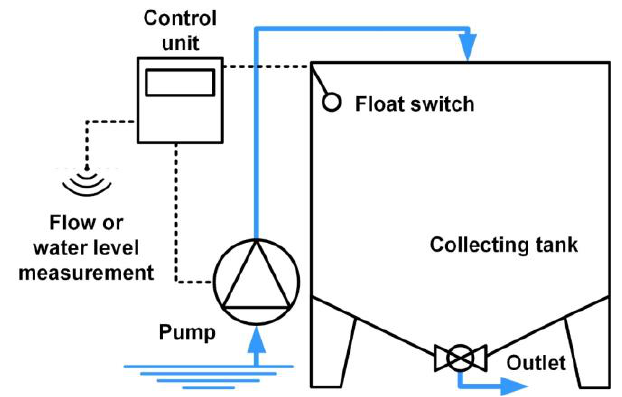
Figure 1. General setup of the large-volume sampler.